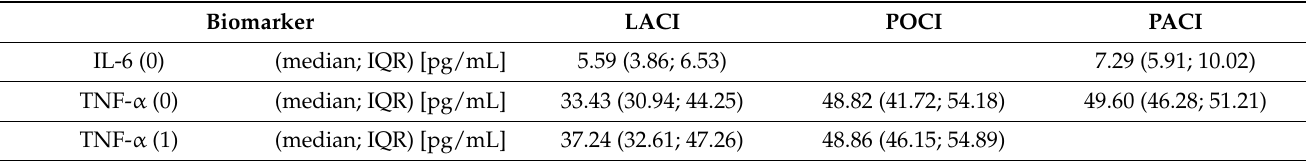
Table 5. Values of biomarkers depending on the types of strokes.